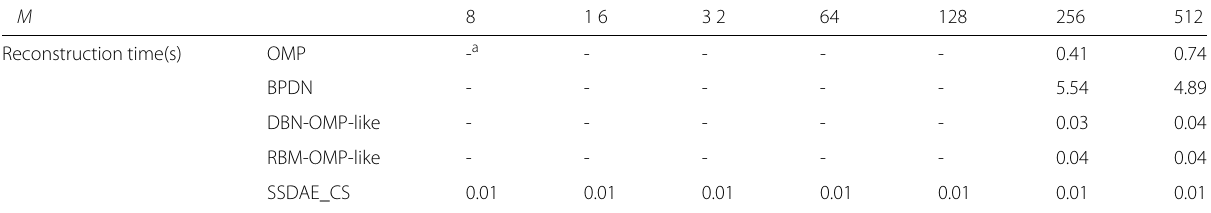
Table 2 Average reconstruction time of MNIST testing set for different M and reconstruction algorithms M Reconstruction time(s)